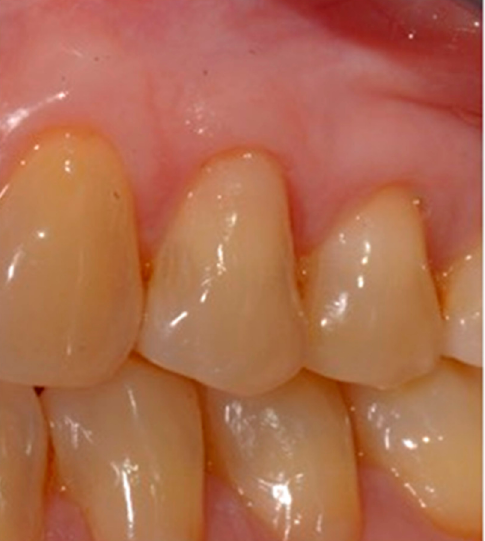
Figure 10. After 15 days from the restoration, the profile was reduced to allow a more coronal gingival adaptation.